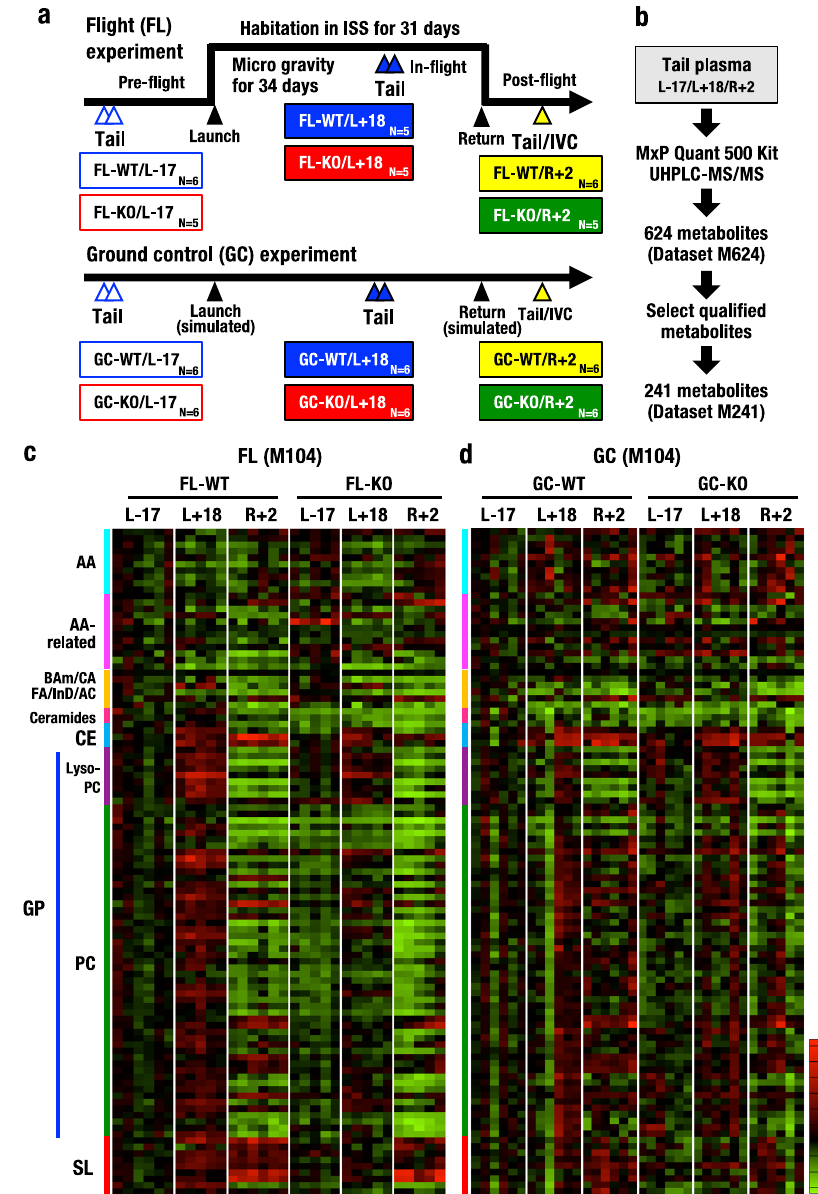
Fig. 1 Plasma collection and metabolome analyses in the MHU-3 project. a Schematic presentation of the MHU-3 project in which space fl ight (FL) and ground control (GC) experiments were performed. Blood samples were collected from the mouse tail at pre- fl ight (L-17; 17 days before launch), in- fl ight (L + 18; 18 days after launch) and post- fl ight (R + 2; 2 days after return) time points. The numbers of mice analysed in this study are noted. b Flow chart of metabolome analyses of tail plasma samples collected at three time points. Plasma samples were submitted for the measurement of 624 metabolites (dataset M624) using UHPLC-MS/MS and an MxP Quant 500 kit. From the M624 dataset, 241 metabolites were quali fi ed and selected for further review (M241). c , d Heatmap analyses for 104 metabolites selected from M241 for FL ( c ) and GC ( d ) experiments with a coef fi cient of variation (CV) value ≤ 30% (dataset M104). Means of FL-WT/L-17 ( c ) or GC-WT/L-17 ( d ) were set to one. The results of M104 are aligned in columns by ID, as described